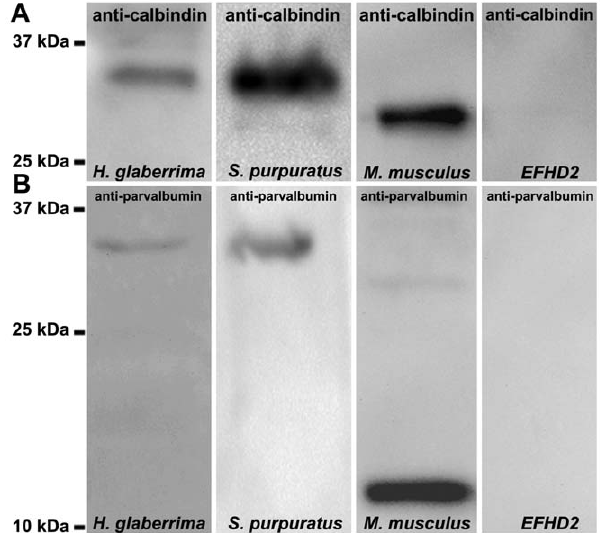
Figure 7. Western blot of holothurian and echinoid radial nerve cords preparations using anti-calbindin 1 and anti- parvalbumin. (A) A 32 kDa immunoreactive band to anti-calbindin 1 was observed in H. glaberrima and L. variegatus radial nerve cords homogenates. A 28 kDa immunoreactive band corresponding to calbindin 1 was observed in the rat kidney positive control and no immunoreactive bands were observed in the synthetic peptide of an EF-hand domain-containing protein negative control. (B) A 32 kDa immunoreactive band to anti-calbindin 1 was observed in H. glaberrima and L. variegatus radial nerve cords homogenates. A 12 kDa major immunoreactive band corresponding to calbindin 1 was observed in the rat skeletal muscle positive control and no immunoreactive bands were observed in the synthetic peptide of an EF-hand domain- containing protein negative